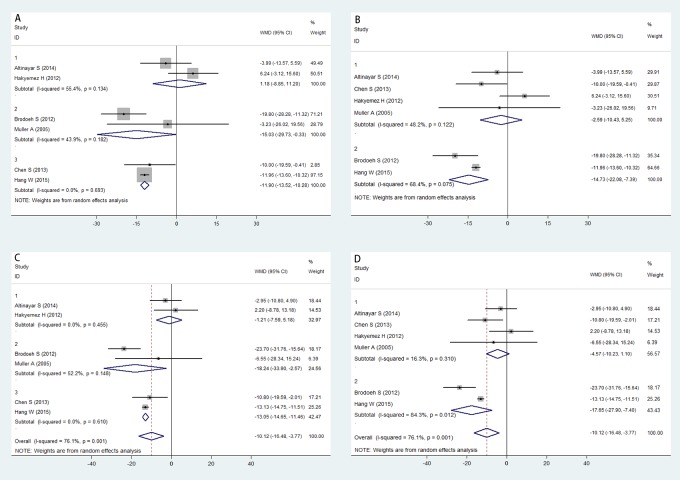
Subgroup analyses with forest plots of the following comparisons: effect of country of origin on the right OB volume (A), effect of magnetic intensity of MRI on the right OB volume (B), effect of country of origin on the left OB volume (C), and effect of magnetic intensity of MRI on the left OB volume (D). The squares represent the WMD estimates for each individual study, and the area of the squares reflects the weight assigned to the studies. The horizontal line across each square represents the corresponding 95% CIs. The diamond represents the summary WMD, and the line width represents the 95% CIs. WMD = weighted mean difference; CI = confidence interval.